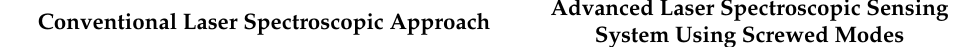
Table 3. The benefits of using screwed modes in the laser spectroscopic sensing systems in comparison with the conventional approach.